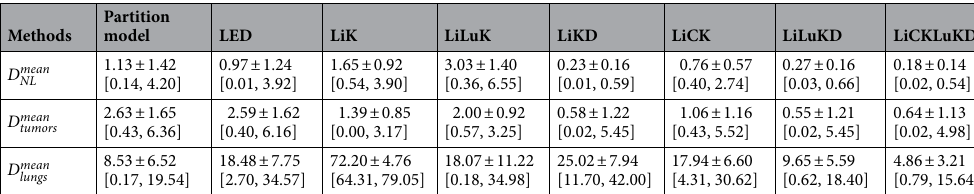
Table 2. Absolute percent differences of D with MC. Mean ± std, [min,